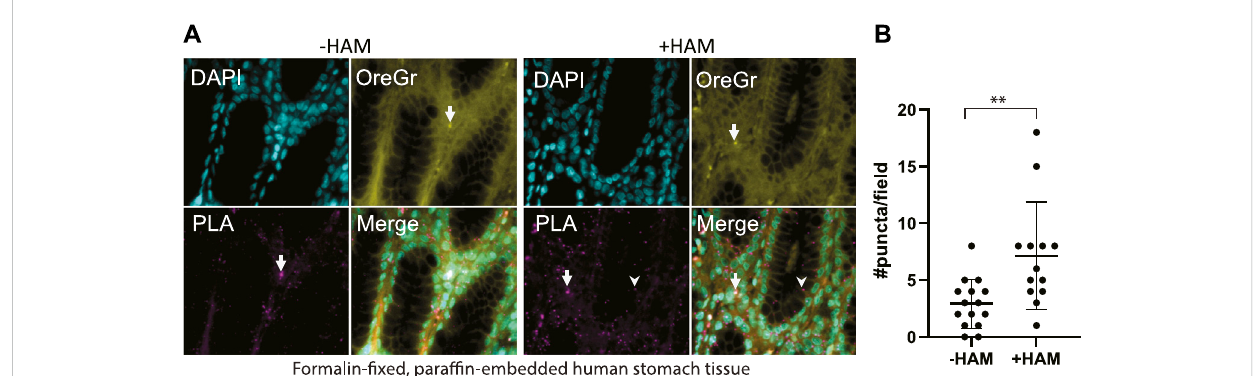
FIGURE 4 (A) Multi-organ tissue arrays were treated with the ABE-PLA. DNA was labelled with DAPI (cyan). Cytosolic staining of cells demarcating the cell boundaryisvisibleintheOregonGreenchannel(Yellow).HydroxylaminetreatmentincreasesthenumberofmagentaPLApuncta(arrowhead)compared to the -hydroxylamine control in the epithelia of the stomach tissue samples. (B) Quanti fi cation of the number of puncta per fi eld in two sample cores. Puncta that are both magenta and yellow (arrow) were not counted. Error bars are standard deviation. (Unpaired Student ’ s T -test ** p -value =